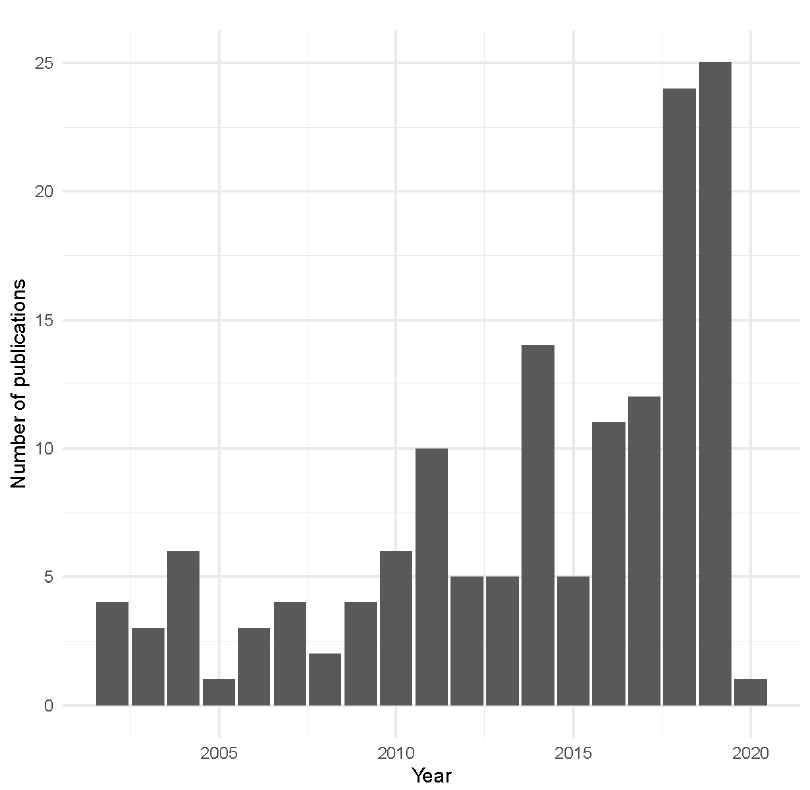
Figure 1. Number of publications contributing to the literature for Trap-Neuter-Release (TNR)